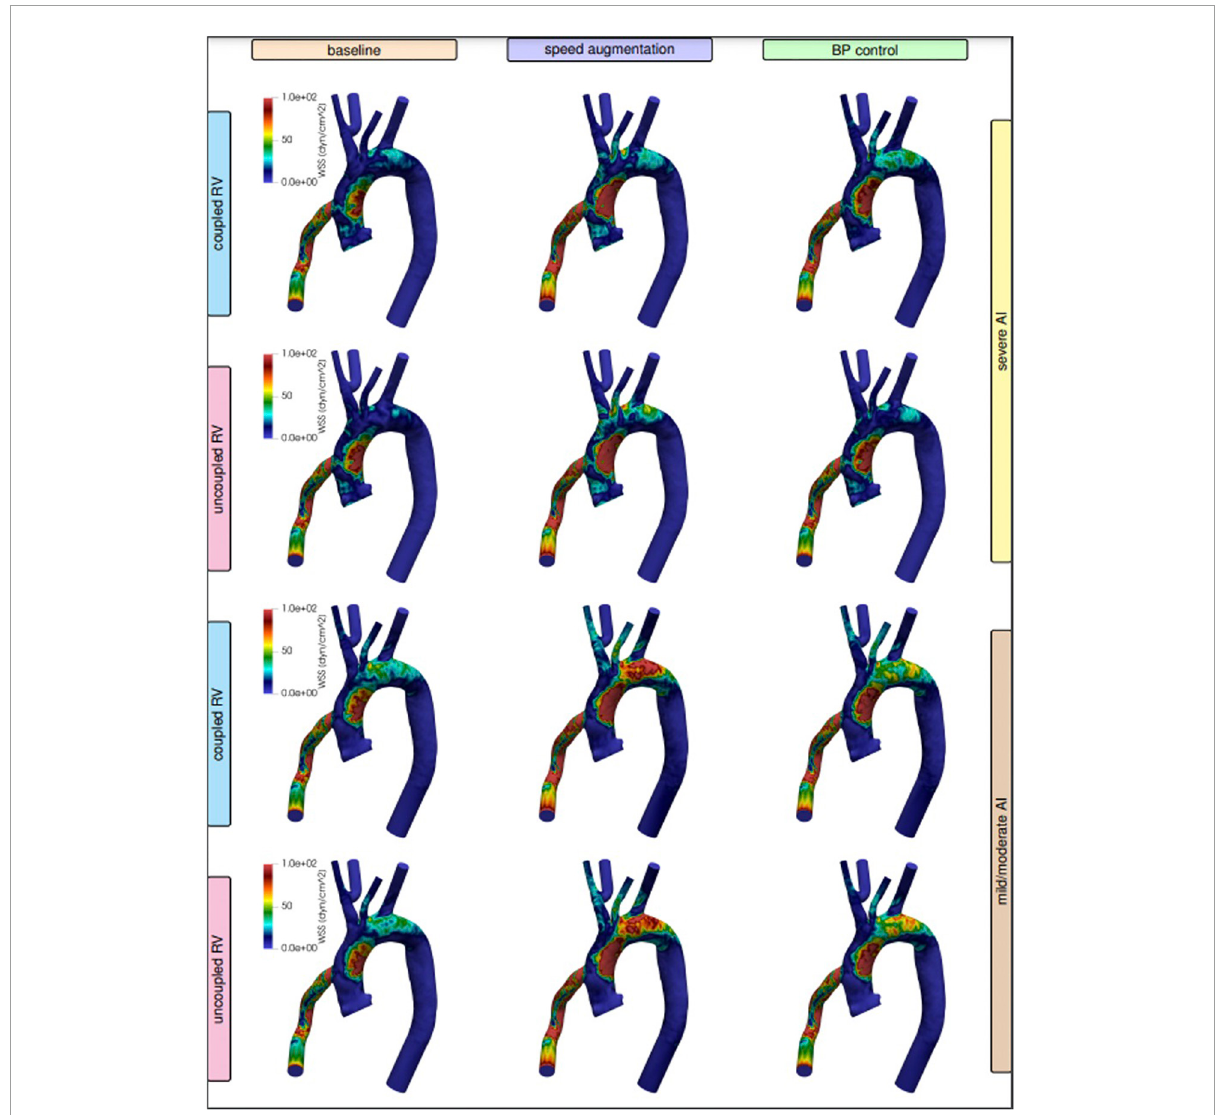
FIGURE3 Visualized wall shear stress stratified by degree of right ventricular (RV) coupling and aortic insufficiency (AI) severity when comparing speed augmentation to blood pressure (BP) control.